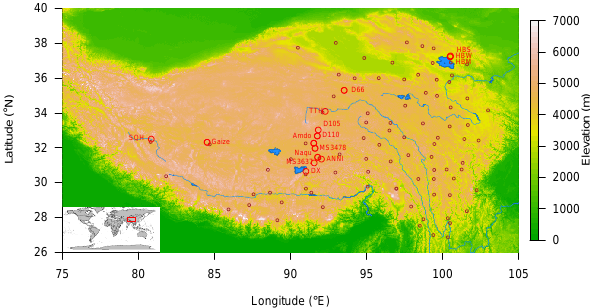
Figure 1. Study area with major lakes, rivers, six regions, validation sites (red large circle), and CMA stations for comparison (red small